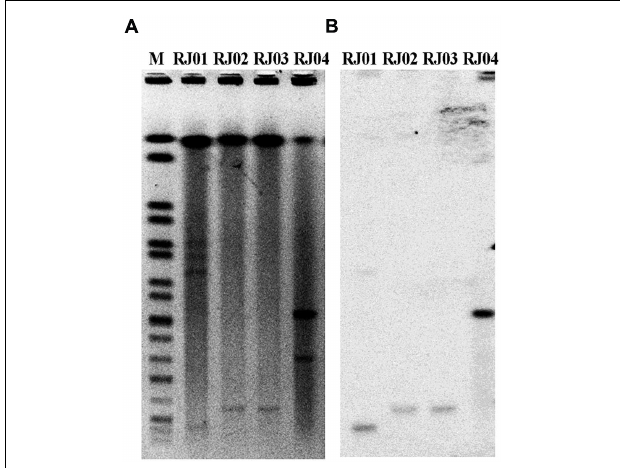
FIGURE 1 | S1-pulsed-field gel electrophoresis (S1-PFGE) patterns of the four bla NDM − 5 -producing isolates (A) and Southern hybridization with a probe specific for bla NDM − 5 (B). M, marker; Salmonella enterica serotype Braenderup